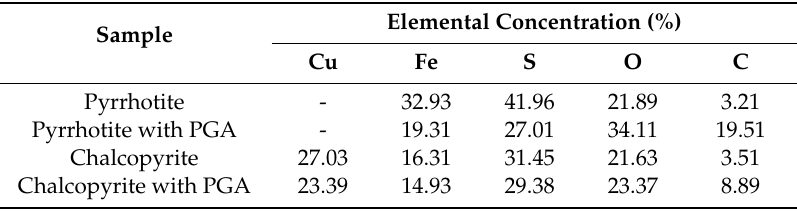
Table 3. Elemental concentration of important species in the absence and presence of 50 mg / L PGA at pH 8.